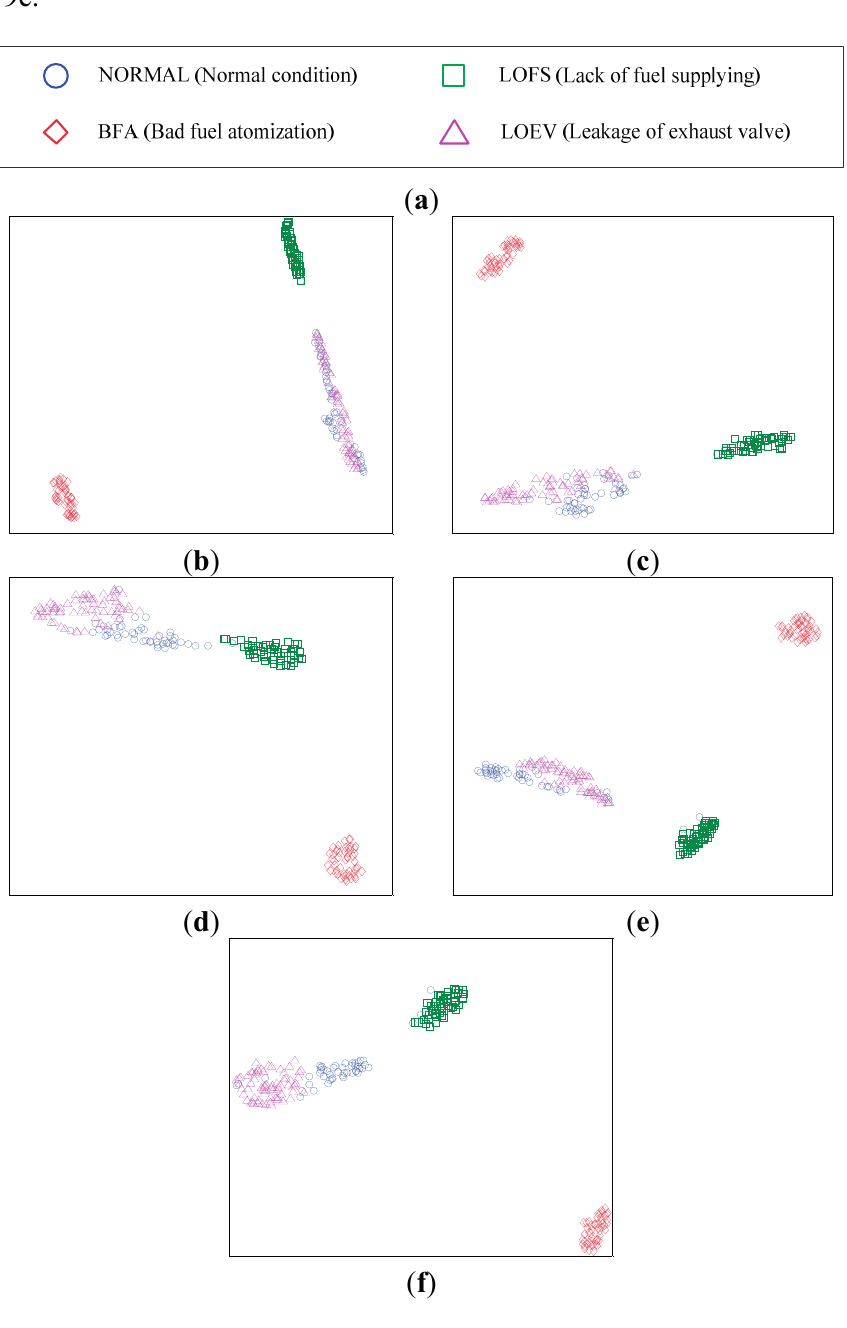
Figure 10. ( a ) Symbols description; ( b ) 55 features; ( c ) 45 features; ( d ) 30 features; ( e ) 15 features; ( f ) 10